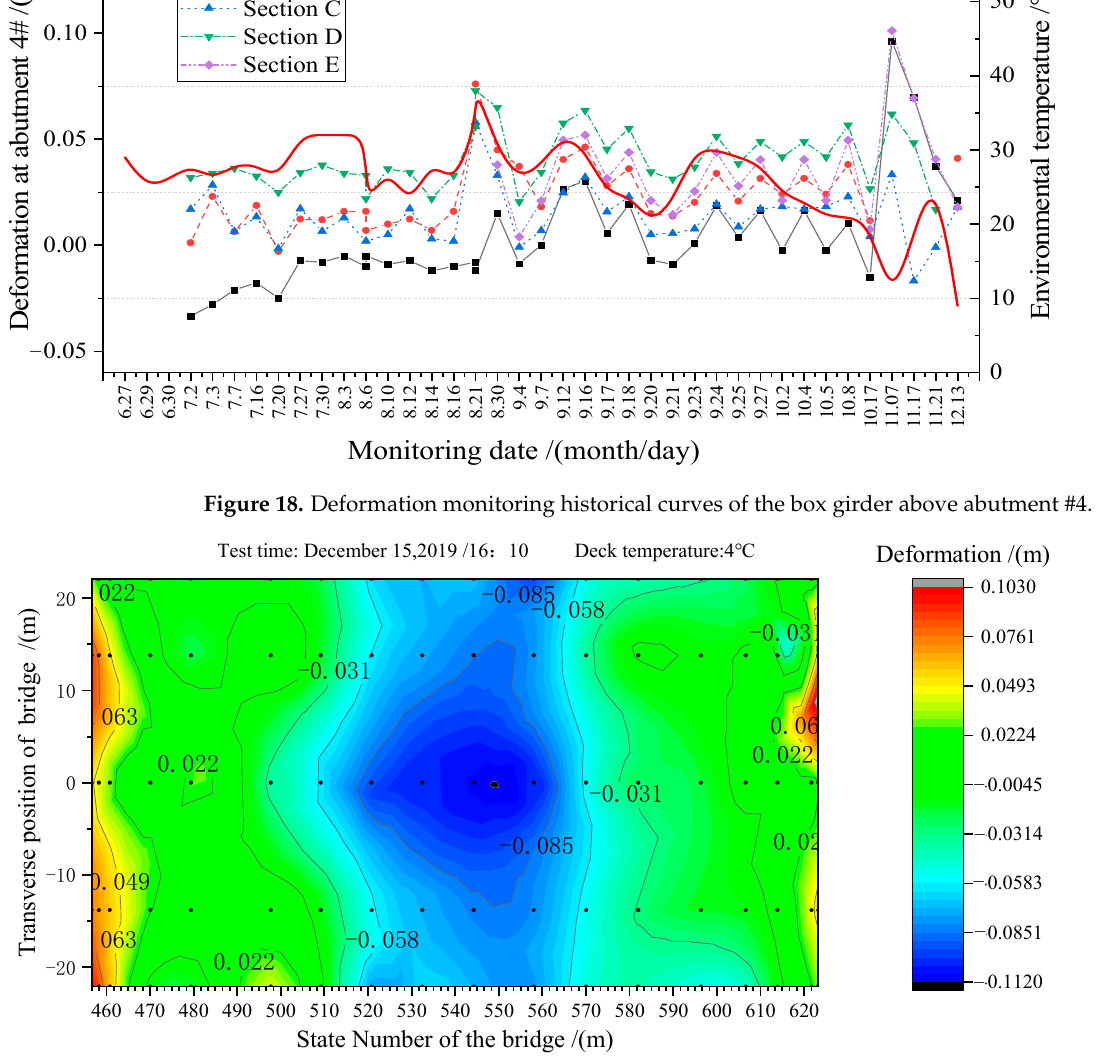
Figure 19. Deformation of the box girder after demolition of the frame scaffolding.